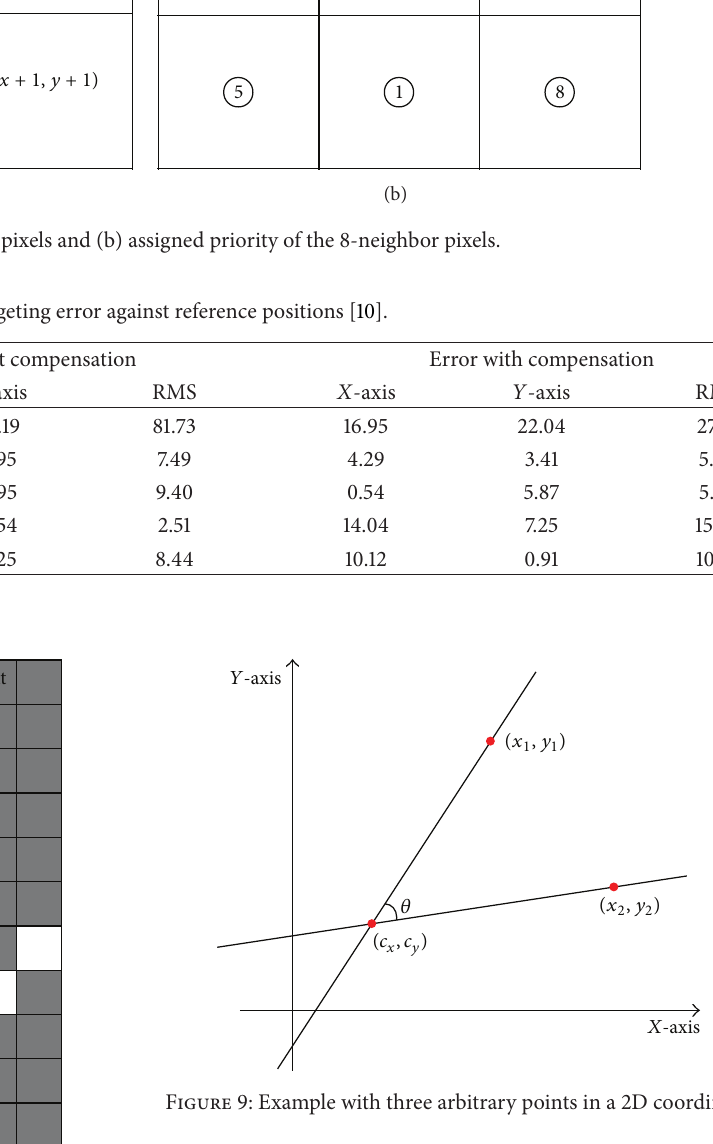
Figure 8: Edge tracking path example for explaining the necessity of the predefined priority (full arrow: normal edge tracking process, dotted arrow: abnormal edge tracking process).